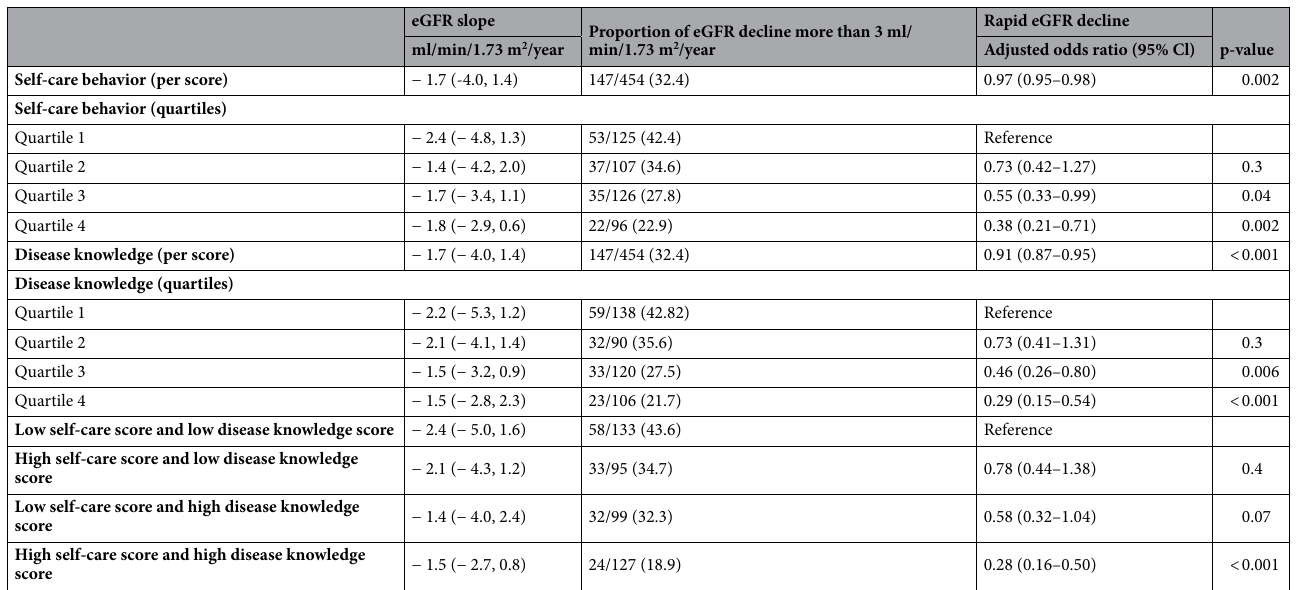
Table 3. The adjusted risks for rapid eGFR decline (eGFR decline more than 3 ml/min/1.73 m 2 /year) within 1 year prior to questionnaire examination in study patients according to self-care behavior and disease knowledge scores. Adjusted for age, sex and all variables in Table 1 whose p-value were < 0.05 including diabetes mellitus, hemoglobin, baseline estimated glomerular filtration rate, and log-formed urine protein- creatinine ratio in unadjusted model. Self-care score quartile cut at 59, 67 and 72. Disease knowledge